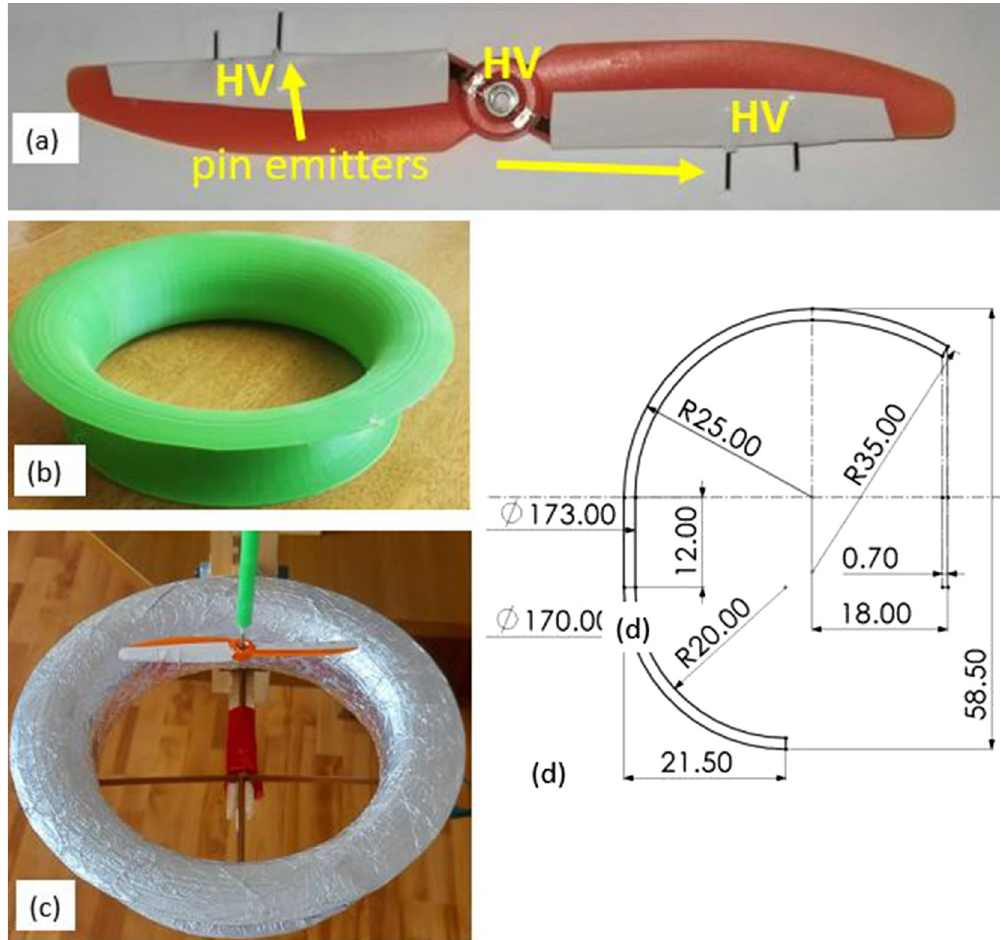
Figure 3. Toroidal RIE: ( a ) ionic propeller design with actual pin positioning (12.6 cm propeller diameter); the propeller is equipped with a ball bearing unit on which high voltage (HV) is applied and distributed via a copper tape to the pin emitters; ( b ) 3-D printed toroid; ( c ) toroidal RIE—the toroid is covered with aluminum foil to form the ground counter-electrode while the propeller is axially positioned above the toroid; ( d ) cross section details of the toroidal counter electrode design; all dimensions are given in